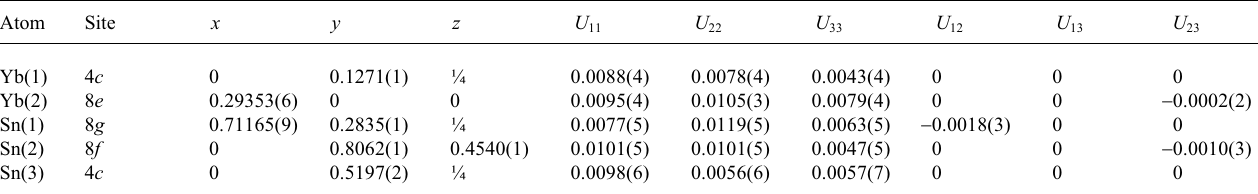
Table 2. Atomic coordinates and displacement parameters (in Å 2